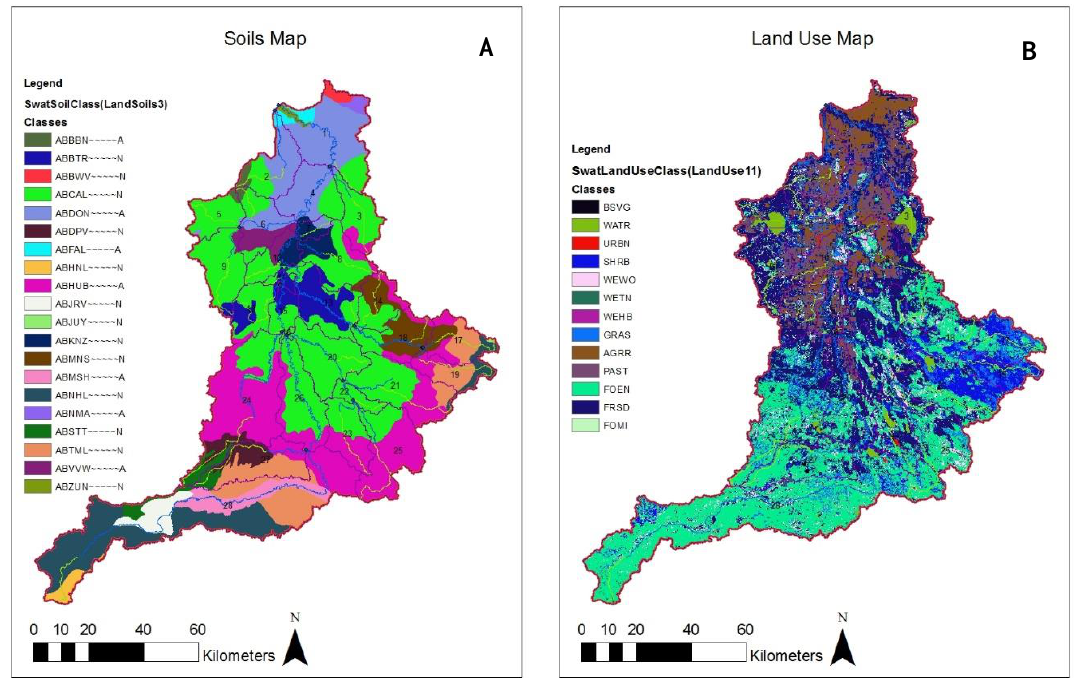
Figure A1. ( A ) Little Smoky River catchment soil types, and ( B ) land use types. The soil and land use types roughly correspond to the elevations at which they are found.